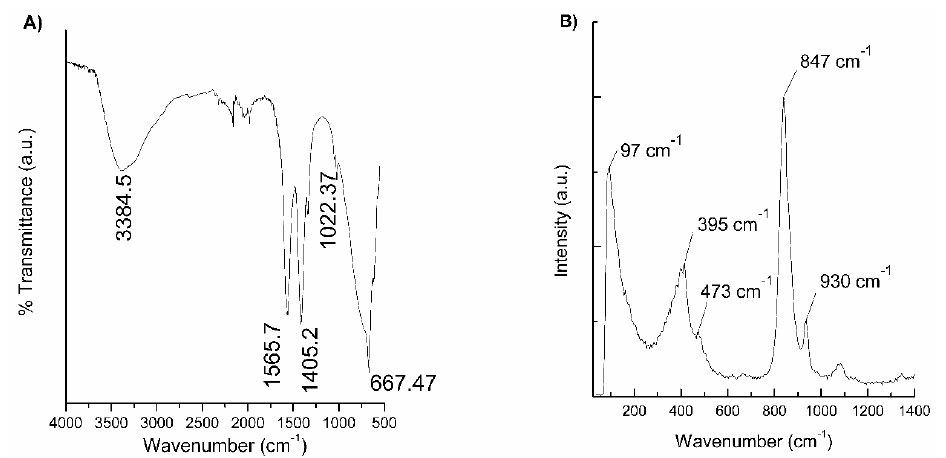
Figure 2. ( A ) Infrared Fourier transform (FT-IR) and ( B ) Raman spectrum for ZnO 2 nanoparticles.